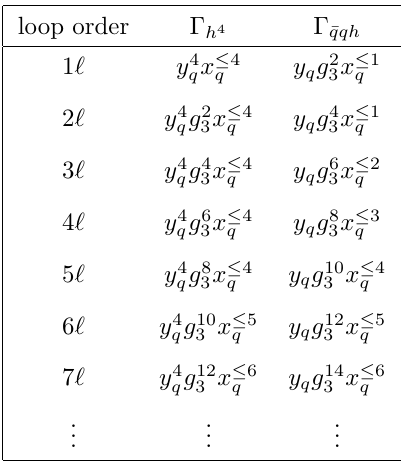
Table 2 . Contributions to Γ n‘